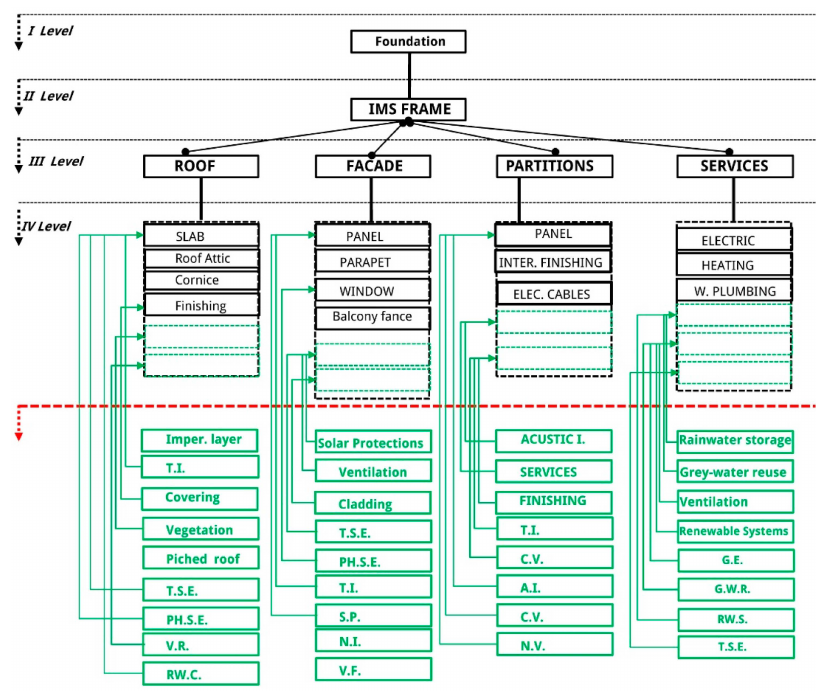
Figure 18. Scheme of systematic approach for integration of energy efficient measures: T.S.E.—thermal solar energy; PH.S.E.—photovoltaic solar energy; S.P.—solar protections; N.I.—natural